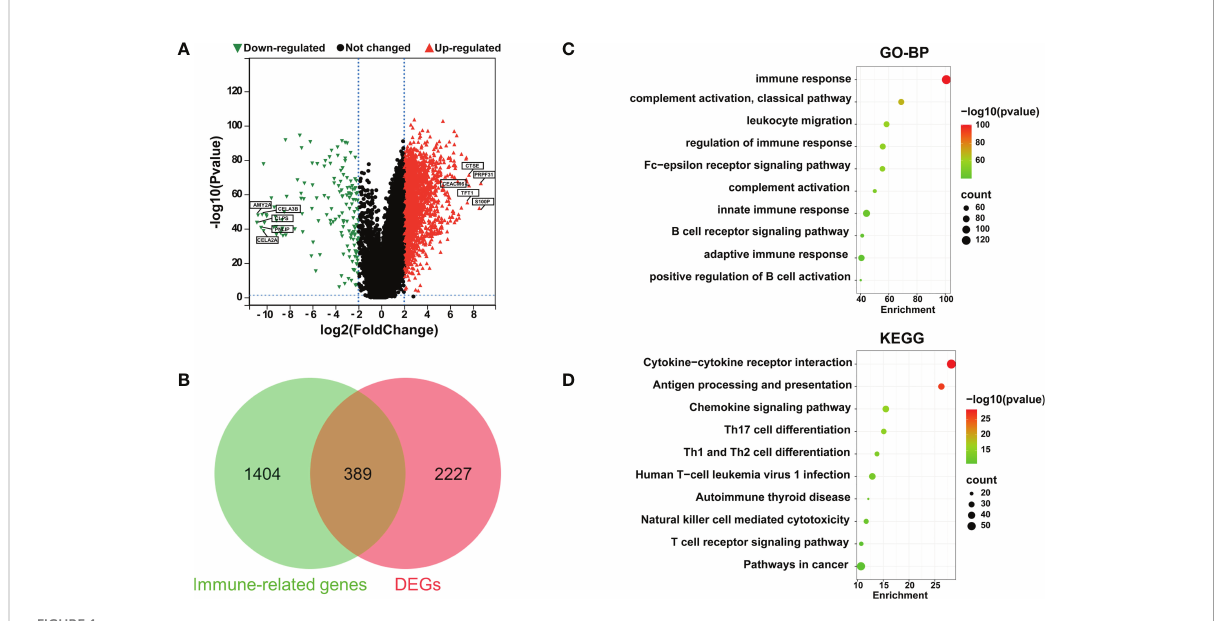
FIGURE 1 Identi fi cation of differentially expressed immune-related genes (IRGs) in PaCa. (A) Volcano plots for DEGs in PaCa; red points are up; green points are down. (B) A Venn diagram was used to analyze immune-related genes and DEGs in PaCa. (C) GO analysis including biological process (BP). (D) Kyoto Encyclopedia of Genes and Genomes (KEGG) enrichment analyses for immune-related DEGs. The color represents the P value, and the point size denotes the number of